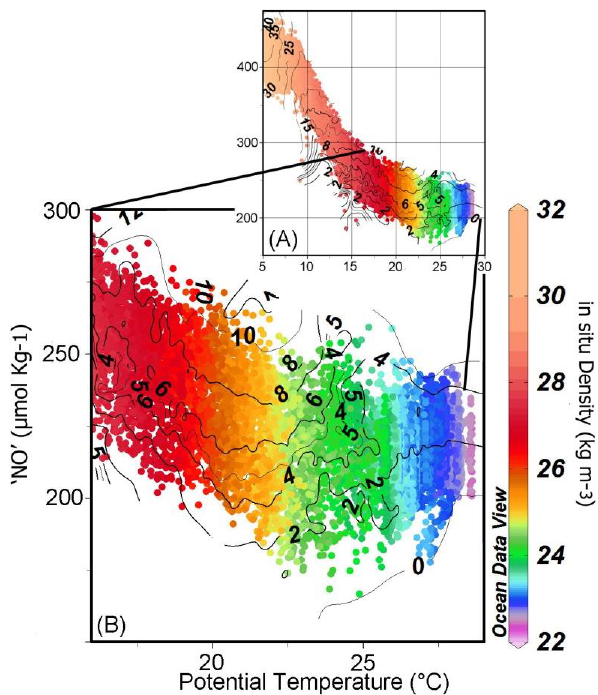
Fig. 7. Plot of “NO” (µmolkg − 1 ) versus potential temperature with in situ density overlay and nitrate concentration contour lines in black from all the data collected in the study area. LDOHN layer at ρ = 24kgm − 3 density isoline, with peaks at ρ = 25–26kgm − 3 isoline. Sharp increase in nitrate concentrations from ∼ 2 to 5–10µmolL − 1 within